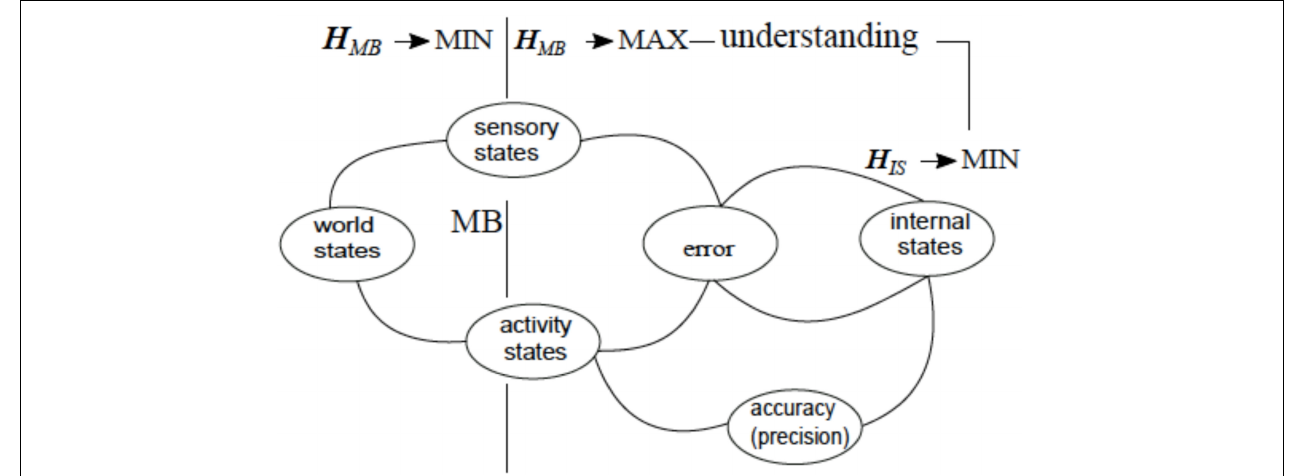
FIGURE 15 | An absence of understanding capacity entails tendency to minimize the entropy in a Markov Blanket while understanding seeks to maximize entropy in MB while minimizing entropy of the internal states [entropy of associative network is maximal if potential connectivity is unrestricted ( Figure 14I ) and minimal when connections are restricted (by coordination demands) and sparse ( Figure 14VI )].